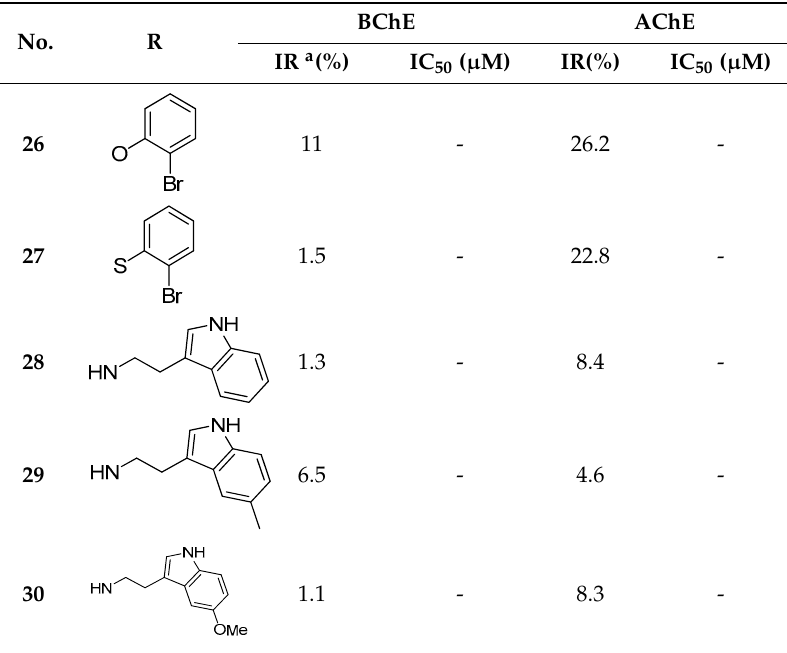
Figure 3. Kinetic study of 23 on BChE inhibition. ( A ) The Lineweaver – Burk reciprocal plots records enzyme velocity curves-substrate concentration in the presence of 23 at different concentrations; ( B ) Plot of slopes versus the concentrations of 23 .